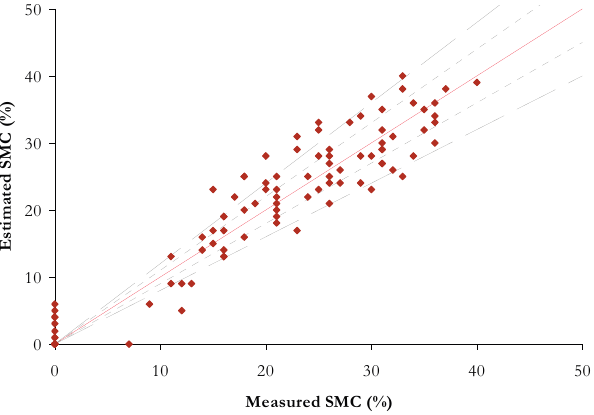
Figure 7. Representation of estimated SMC with the inverse model according to measured SMC for the a priori soil class 3. The dashed black lines represent the boundaries of an error of 20%.